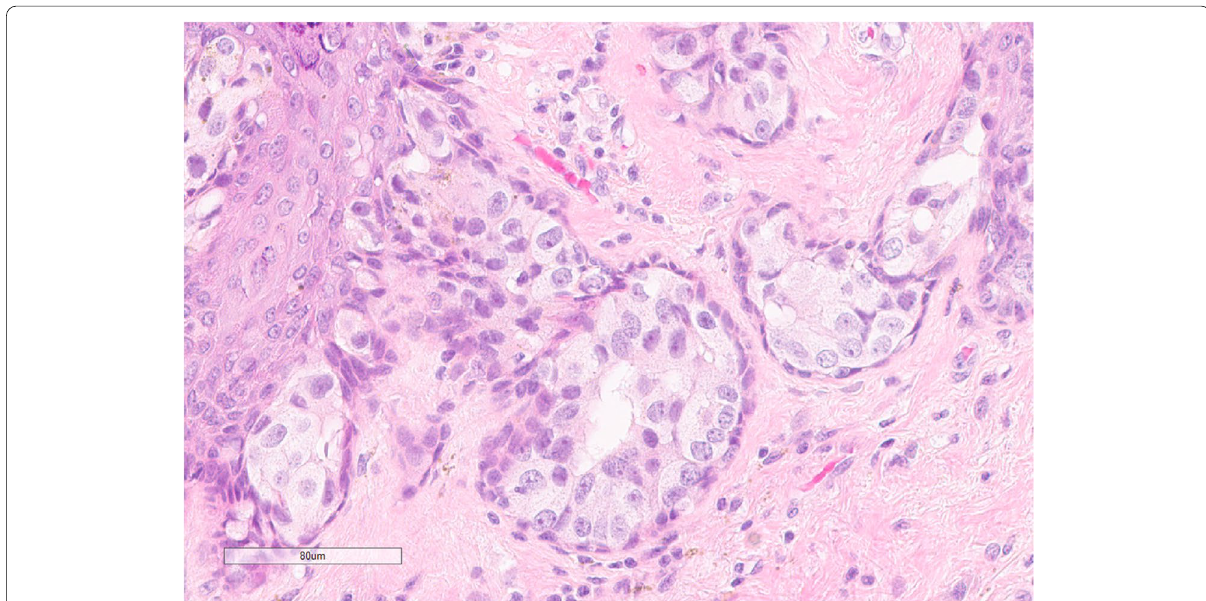
Fig. 2 Detail of Paget’s cells: cluster of cells with abundant, pale and amphophilic cytoplasm, pleomorphic nuclei, and prominent nucleoli. H.E.